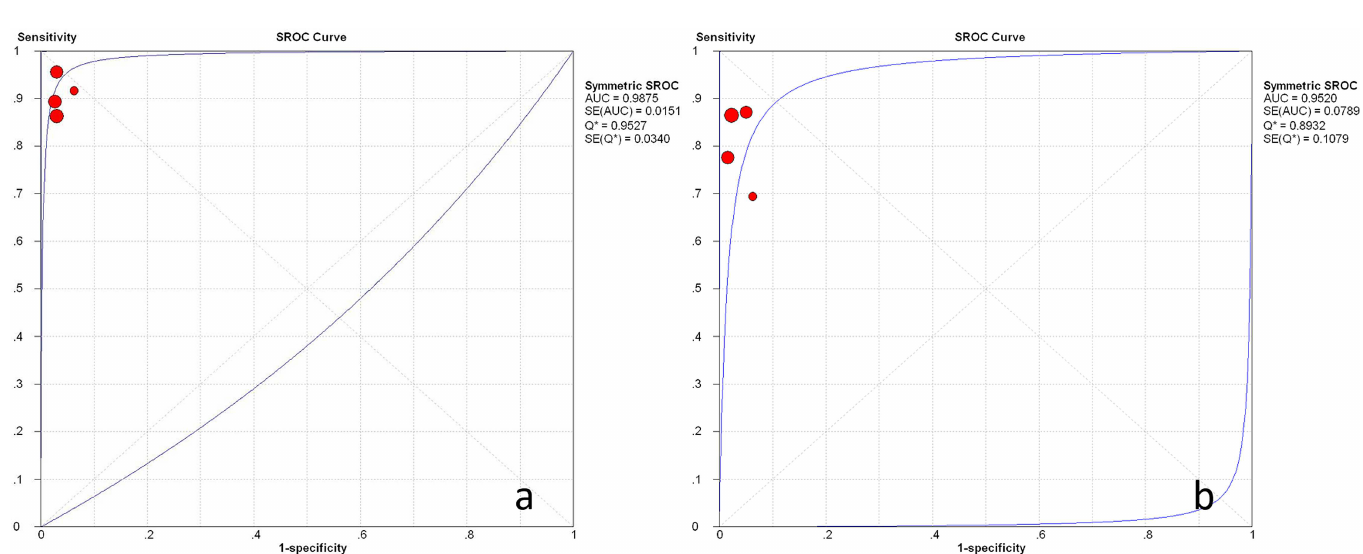
Fig 8. Weighted summary receiveroperating characteristic (SROC) curve, with 95% confidence interval (CI), for studies involved. a ROSE group; b non-ROSE